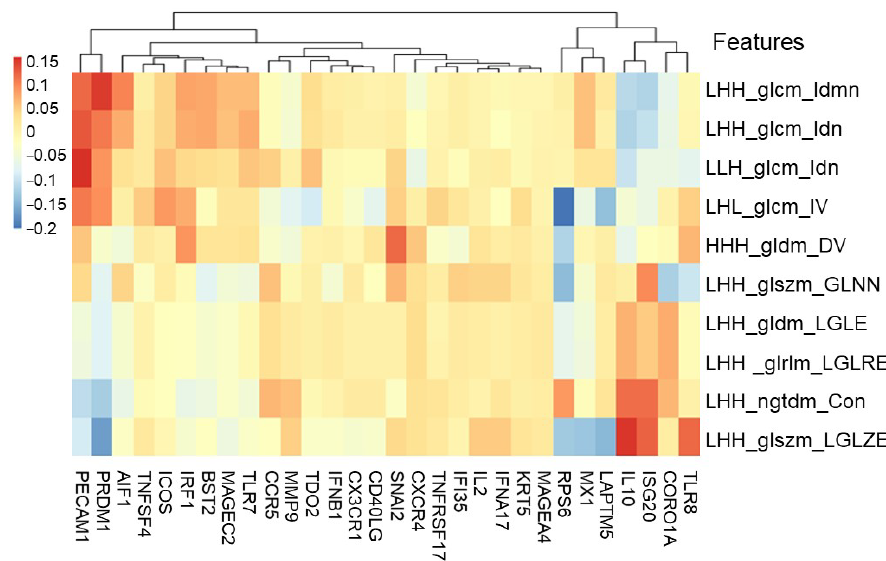
Figure 4. Heatmap visualization based on 10 significant adjusted radiomic features and immune gene expression. The correlation between adjusted radiomic features and immune gene